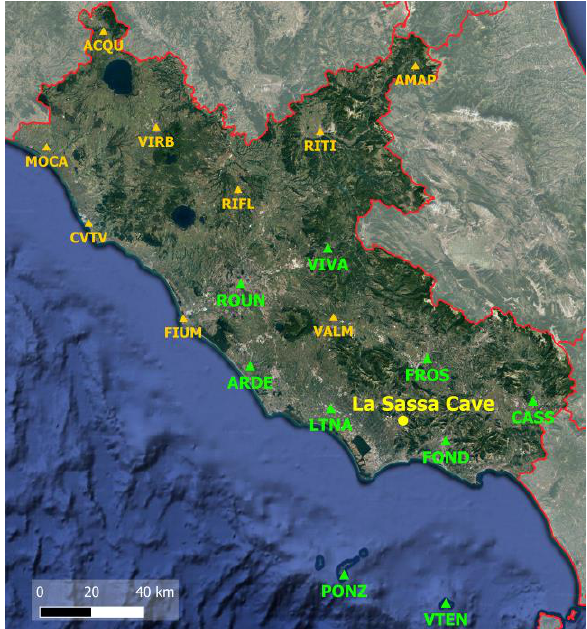
Figure 2 – The permanent GNSS stations of the Lazio Region: in green the stations used in the computation of the